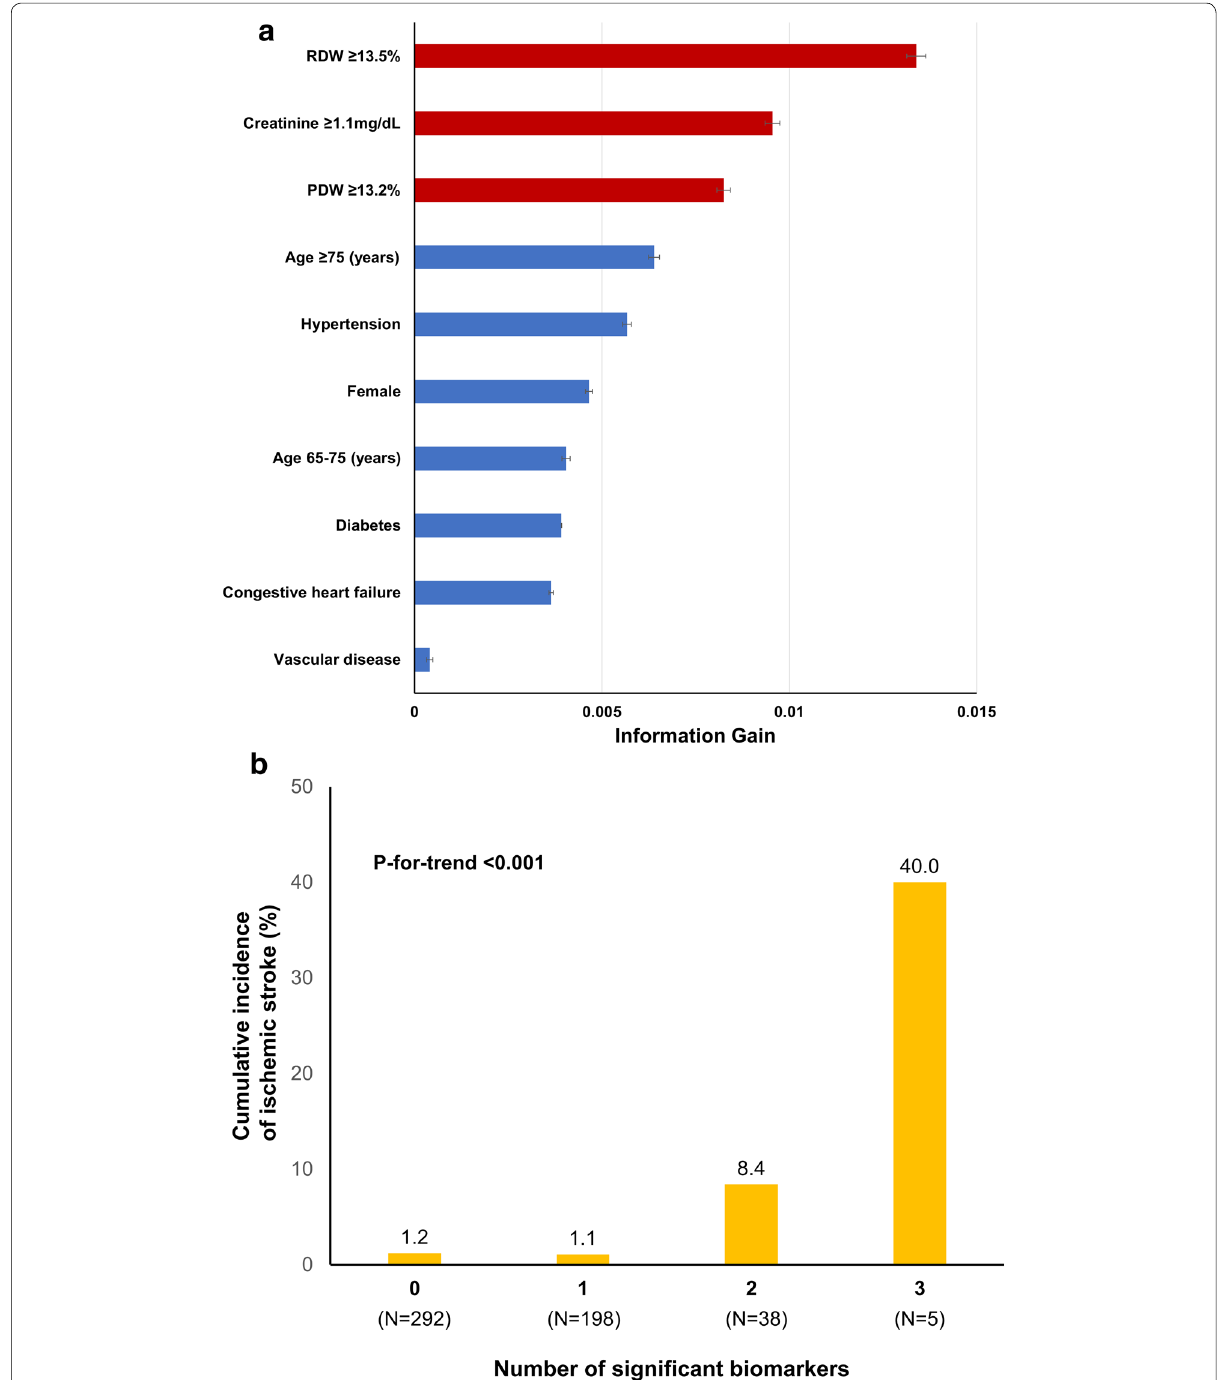
Fig. 2 a Relative importance of significant biomarkers and clinical risk factors in the prediction of ischemic stroke. b Cumulative incidence of ischemic stroke according to the number of significant biomarkers. The significant biomarkers were RDW PDW 13.2%. PDW, platelet distribution width; RDW, red cell distribution ≥